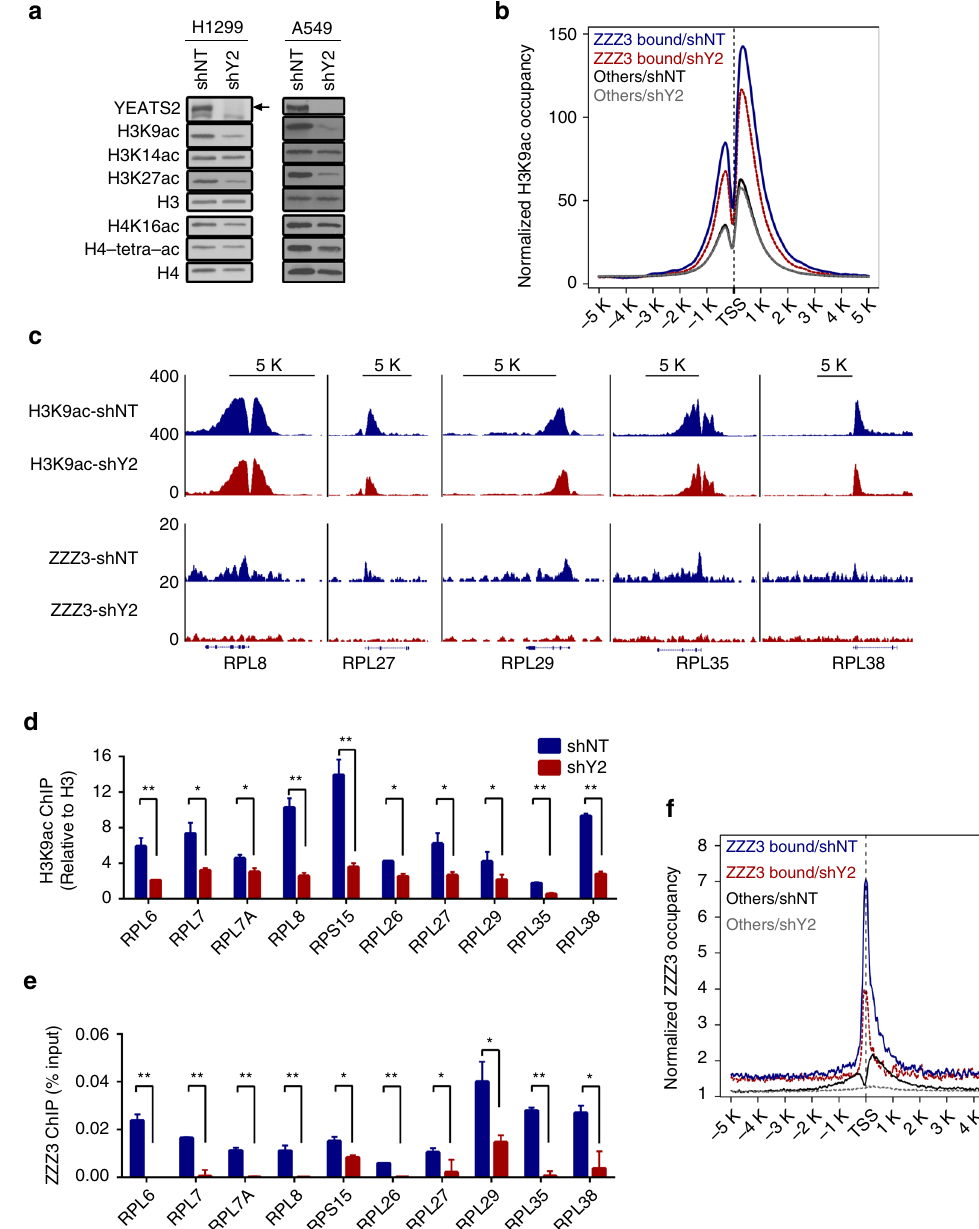
Fig. 5 YEATS2 is required for ATAC-dependent maintenance of histone H3K9ac on the ribosomal protein genes. a Western blot analysis of YEATS2 and H3 and H4 acetylation in control (shNT) and YEATS2 KD (shY2) cells. H3 and H4 were used as a loading control. The arrow indicates the band of YEATS2 protein. b Average genome-wide H3K9ac occupancy on the promoter (5 kb ± TSS) of the ZZZ3-bound genes or non-ZZZ3-bound genes (others) in control (shNT) and YEATS2 KD (shY2) H1299 cells. c Genome-browser view of the H3K9ac and ZZZ3 ChIP-seq peaks on the indicated ribosomal protein genes in cells as in ( b ). d qPCR analysis of H3K9ac ChIP of the indicated ribosomal protein genes in cells as in ( b ). e qPCR analysis of ZZZ3 ChIP of the indicated ribosomal protein genes in cells as in ( b ). f Average ZZZ3 occupancy on the promoter (5 kb ± TSS) of the ZZZ3-bound genes or non-ZZZ3-bound genes (others) in control (shNT) and YEATS2 KD (shY2) H1299 cells. In d and e , error bars indicate S.E.M. of at least three biological replicates. * p < 0.05; ** p < 0.01 (Student ’ s t